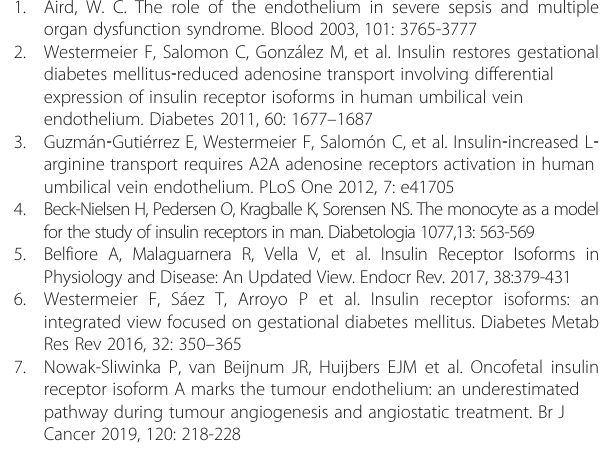
Fig. 2 (abstract P22). Long-term outcomes on septic × non-septic